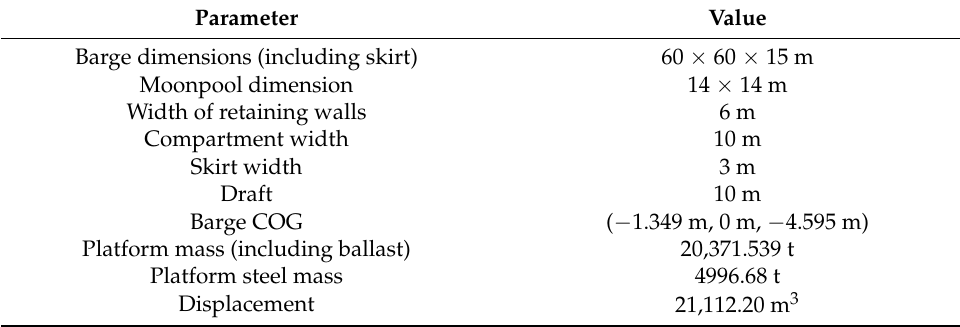
Table 4. General specifications of the barge-type platform.